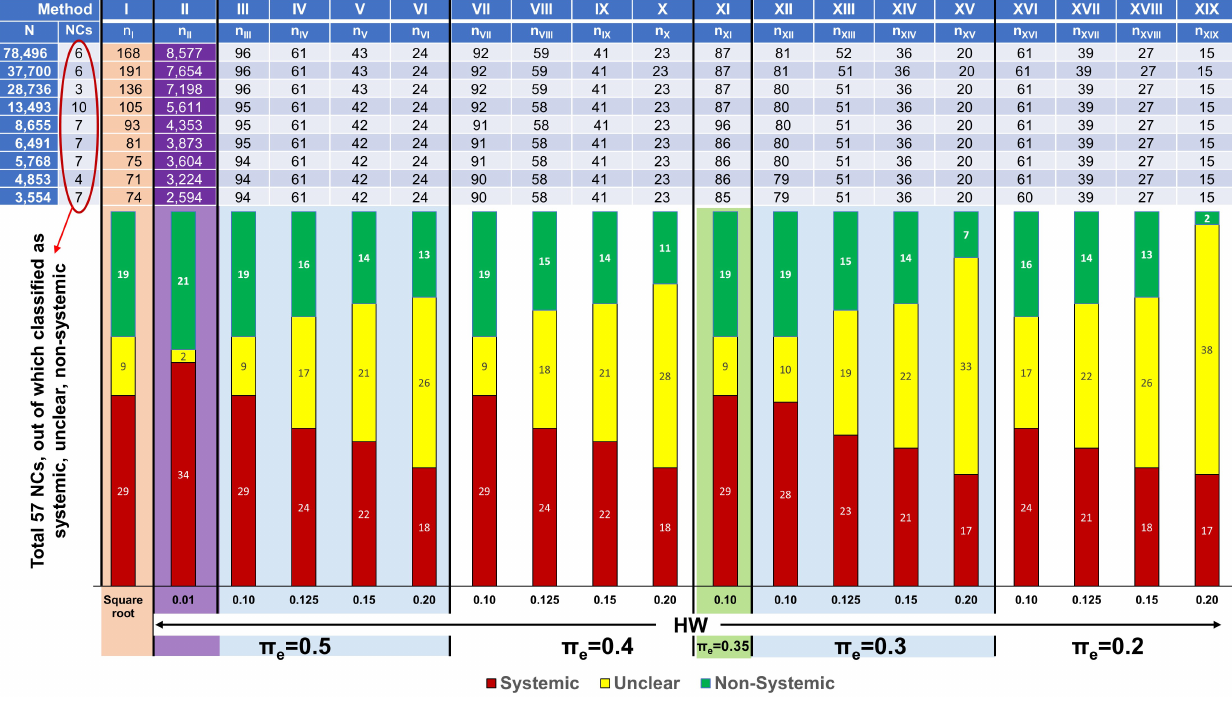
Figure 9. Evaluation of inspection results from nine large organic producer groups. The size of the groups ( N ) is indicated in the left column of the table on top of the graph. The second column of the table shows the number of NCs occurring in each group. For the nine groups together, a total of 57 NCs had been identified (red circle). The third column of the table (Method I) shows the real sample sizes, which were used by CERES, based on the square root approach (for extremely large groups, CERES has been using a risk factor < 1 , therefore some of the samples are smaller than the square root). The sample sizes for Methods III to XIX were calculated using Equation 10, with different values for π e (from 0.5 to 0.2) and HW (from 0.10 to 0.20). For demonstration purposes, also the sample for π e = 0 . 5 and HW = 0 . 01 was calculated (Method II, in purple), resulting in extremely high sample sizes. As reflected in the table on top, the sample sizes vary substantially between methods, but very little between groups. The incidence of each NC was then calculated proportionally to the sample size. Then the classification of each NC was computed for each sample size, using the method described in Section 4. The red colour means the systemic condition of the NC was confirmed, the yellow colour means the systemic condition is unclear, because the threshold for qualifying an NC as systemic or not, lies between the lower and the upper limit of the confidence interval. The green colour means the NC is non-systemic. With decreasing sample size, the number of unclear cases increases. The only result with only two unclear cases was obtained with an unrealistically large sample (Method II), followed by Methods III, VII and XI, with nine unclear cases each. We therefore suggest to use π e = 0 . 35 and HW = 0 . 1